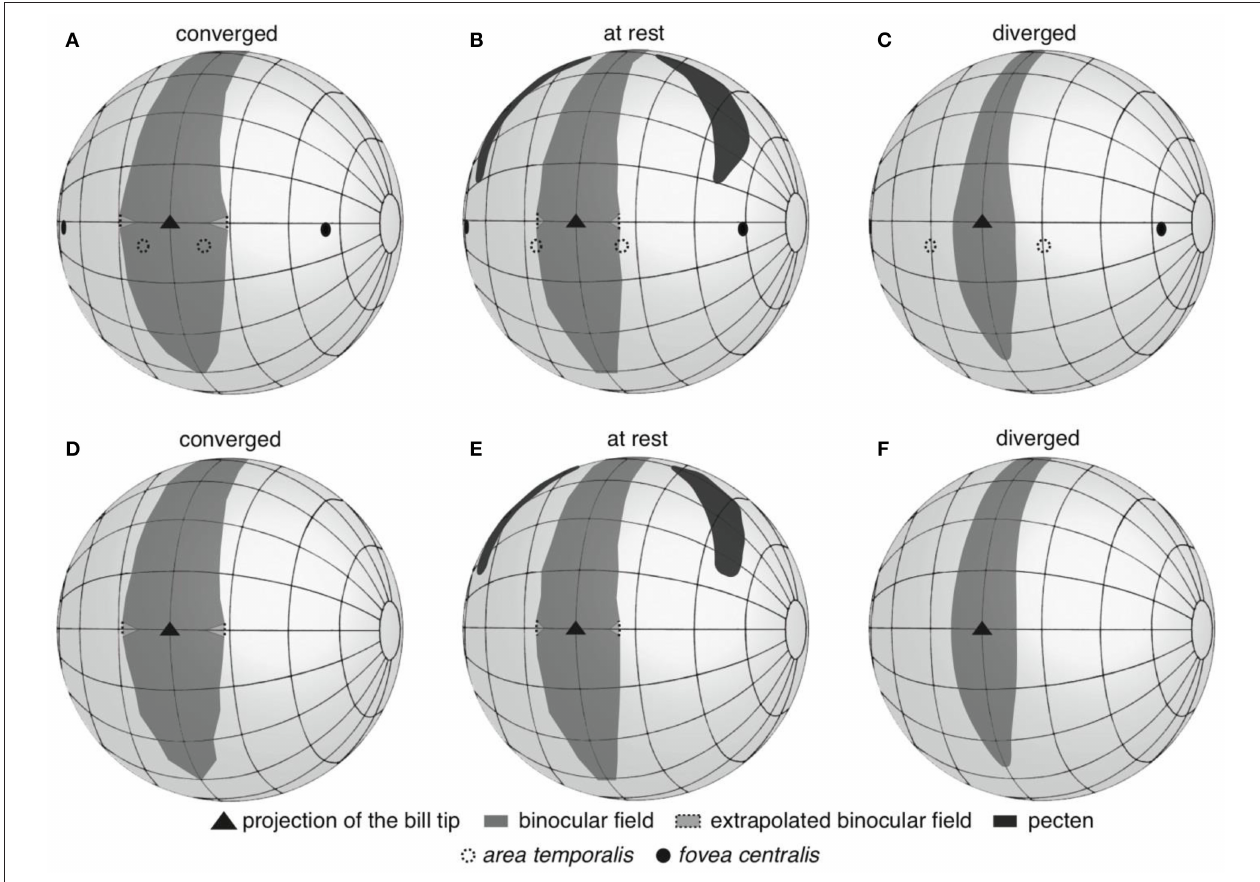
FIGURE 2 | Three-dimensional representations of anterior hemisphere of the visual fields of Anna’s (A–C) and Rufous (D–F) hummingbirds. Panels are labeled according to whether the panel presents the eyes moved forward in a converged state, resting in an at rest state, or moved backward in a diverged state. The projections of retinal specializations are depicted for Anna’s hummingbirds; retinal data was not available for Rufous